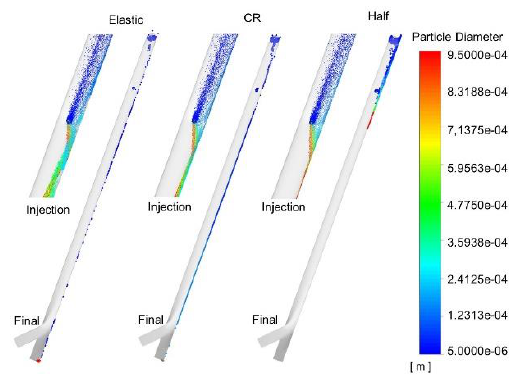
Fig. 6. CFD simulation at 1.5 m/s and 15° of inclination angle, for the three CoR evaluated.